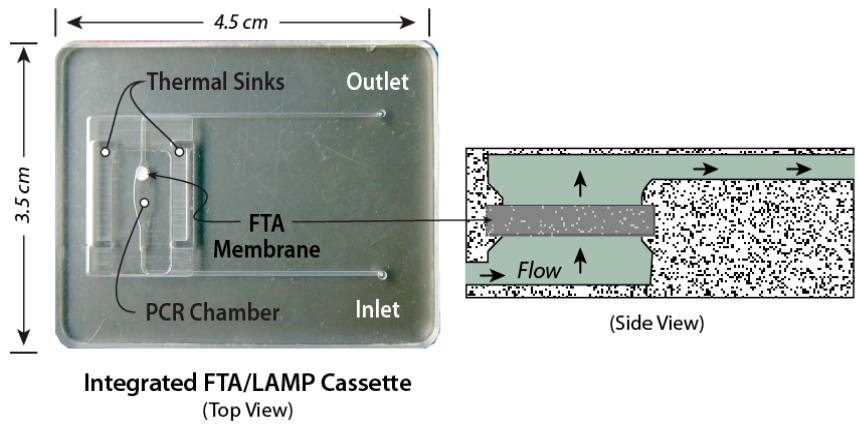
Figure 3. Microfluidic molecular diagnostics chip made as bonded polycarbonate laminate. Figure Amplification (“PCR” or isothermal) chamber volume is 25 μ L. Inlet channel has a porous ‘membrane’ disc (~1 mm thick and 2 to 3 mm in diameter) comprised of Whatman FTA™ cellulose or silica glass fiber. Inflow of sample lysate (lysing and nucleic acid binding agent, e.g., guanidium HCl)